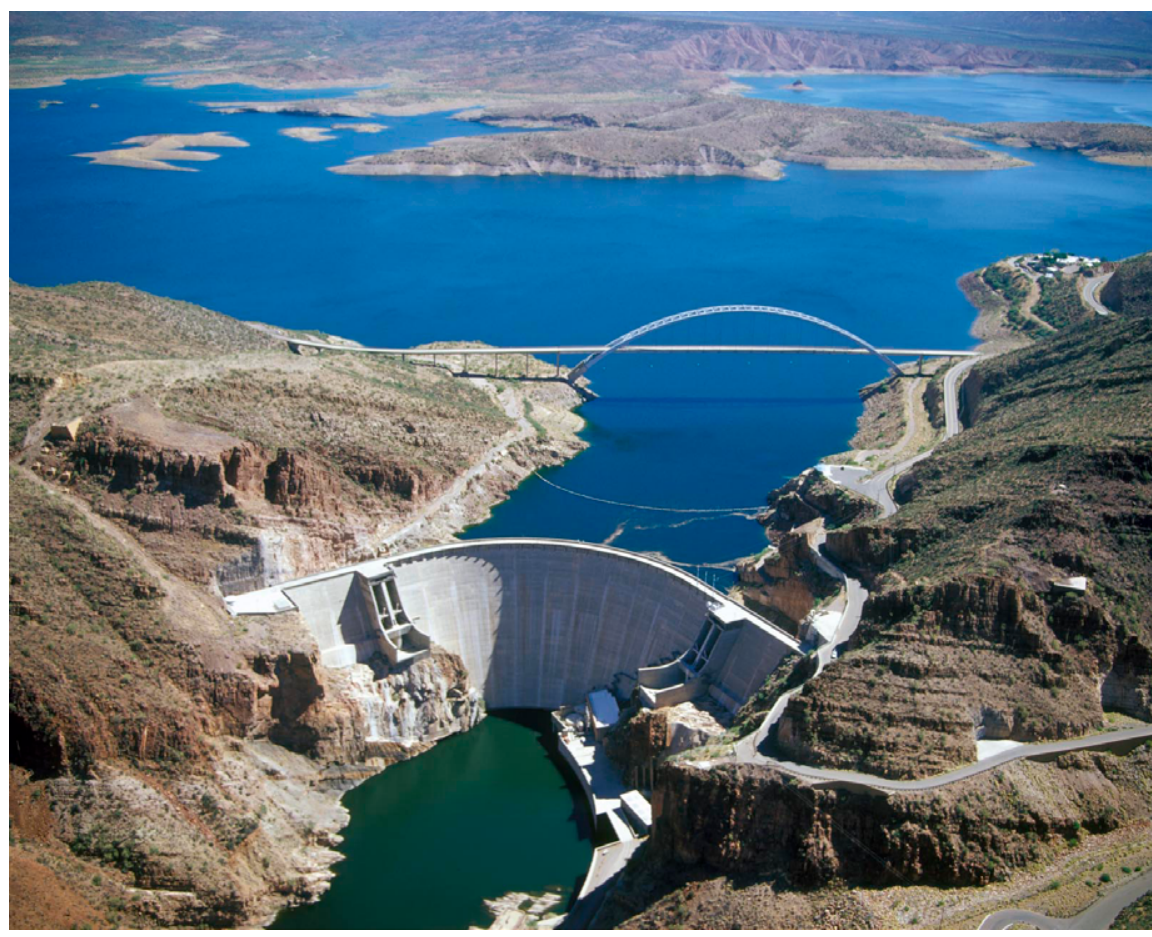
Human Dam Theodore Roosevelt Dam [https://commons.wikimedia.org/wiki/